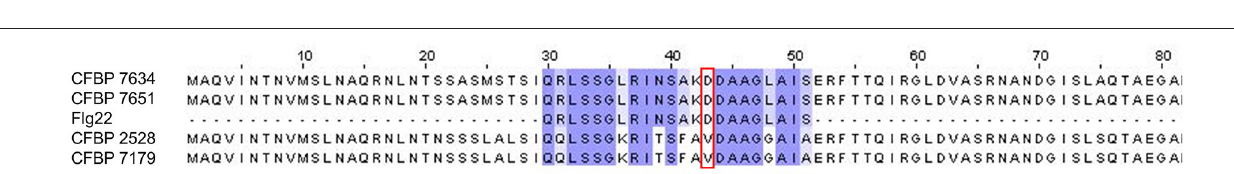
FIGURE 8 | Multiple alignment between the flagellin FliC N-terminal regions of the 4 X. arboricola strains and the flg22 peptide. The “D” to “V” switch between nonpathogenic and pathogenic strains is shown with the red